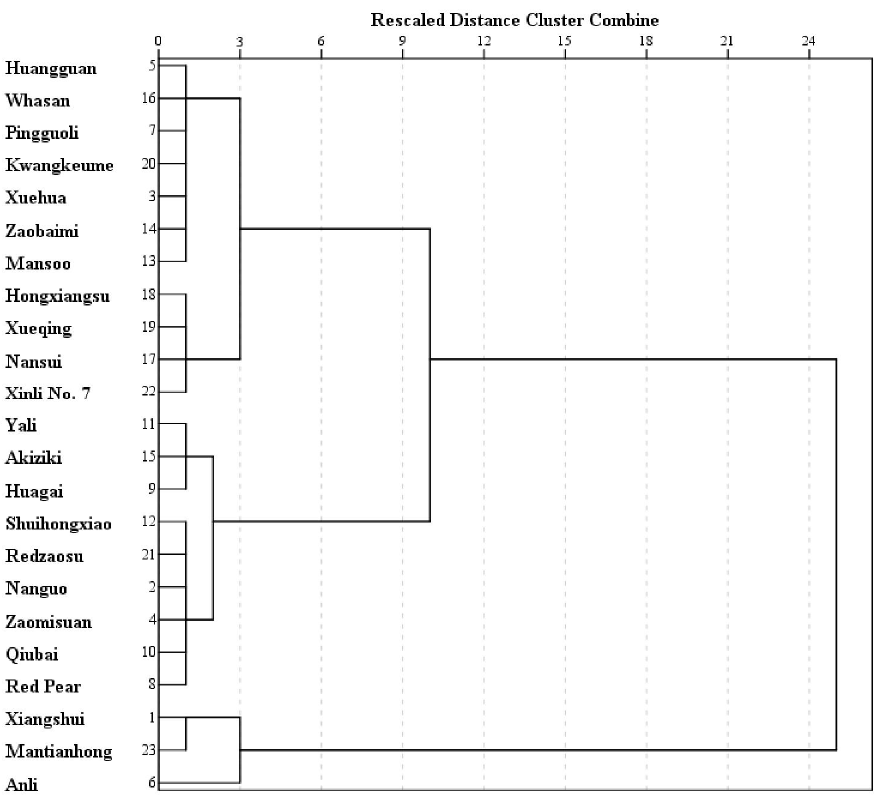
Figure 2. Cluster analysis of pear pastes from 23 cultivars.